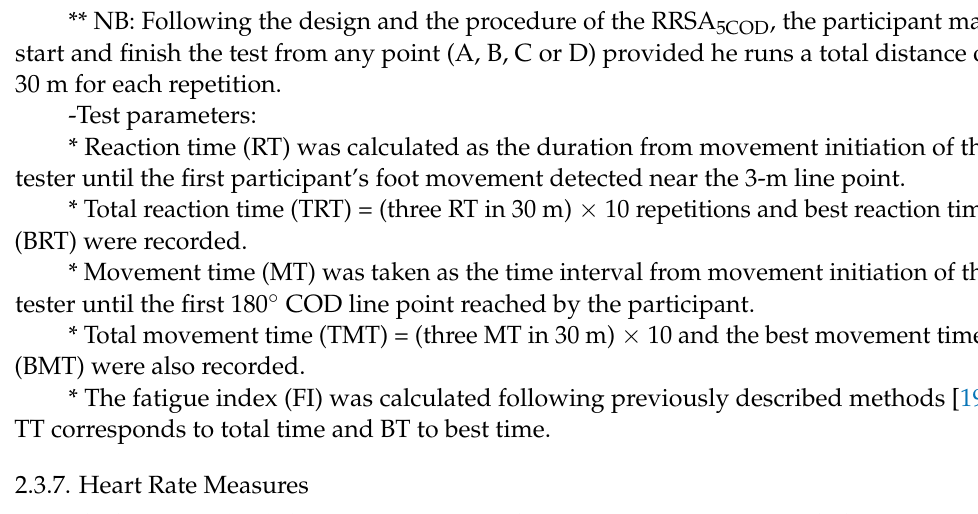
Figure 2. Graphical representation of the reactive multi change of direction (RRSA 5COD )